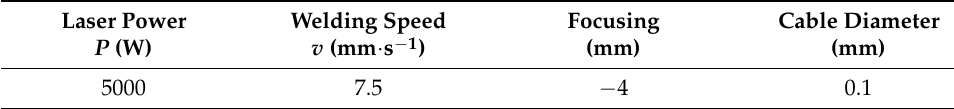
Table 4. Parameters of laser welding.